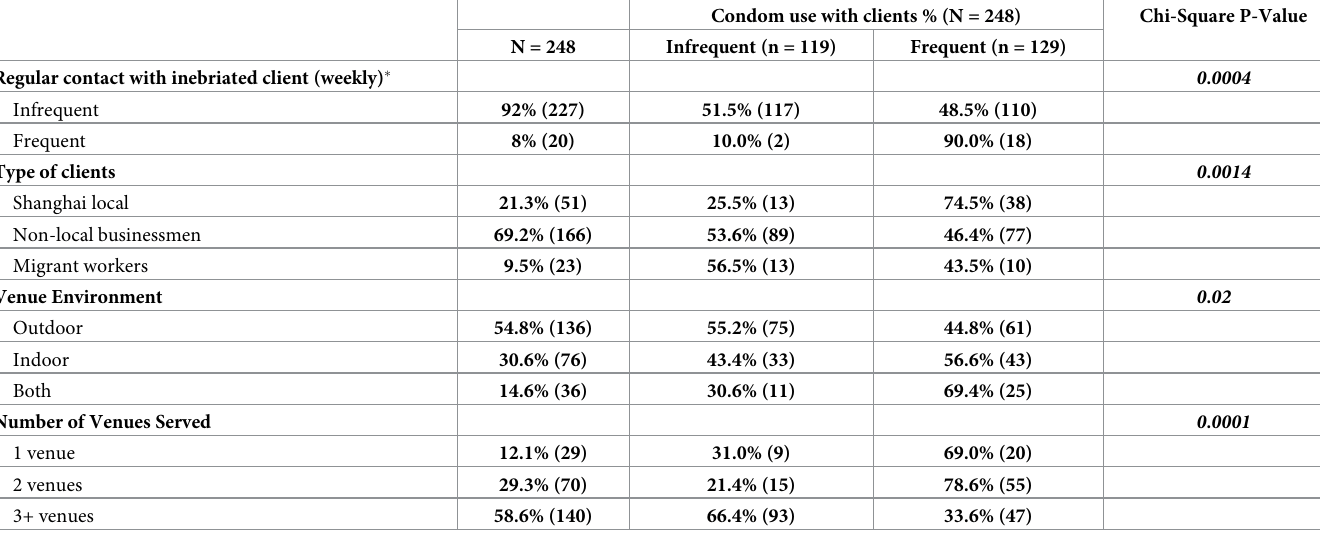
Table 2. Client and venue characteristics by condom use status among street-based sex workers in Shanghai,